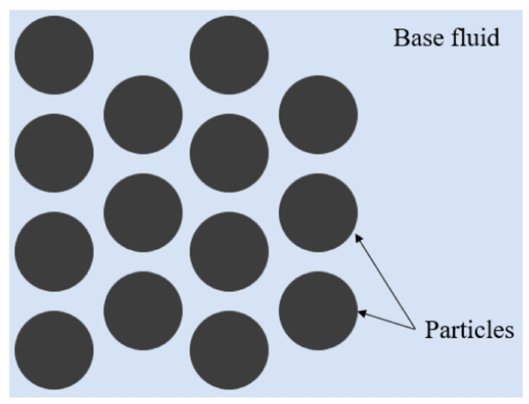
Figure 36. Effective medium theory static and homogenous